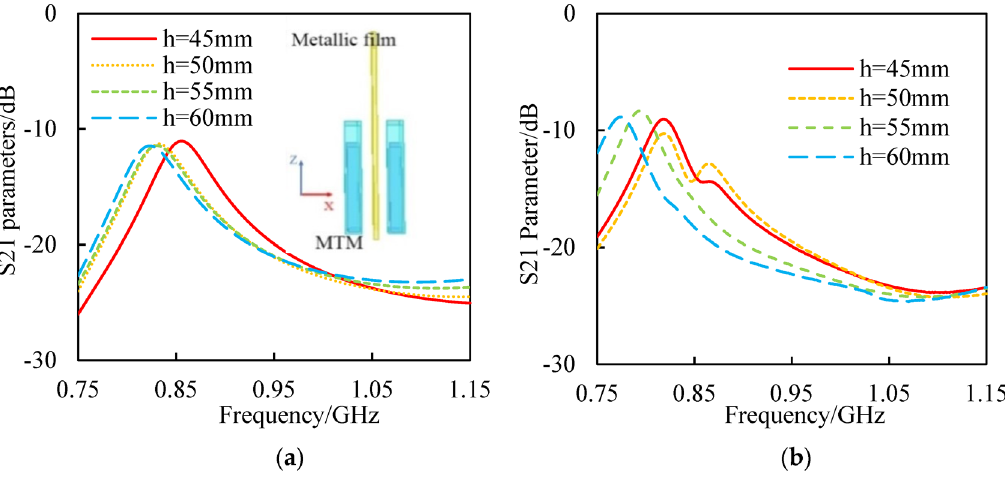
Figure 5. S 21 parameters of the system with the unilateral water-based MTM particle with different water height from ( a ) simulation and ( b ) experiment. water height from ( a ) simulation and ( b ) experiment.